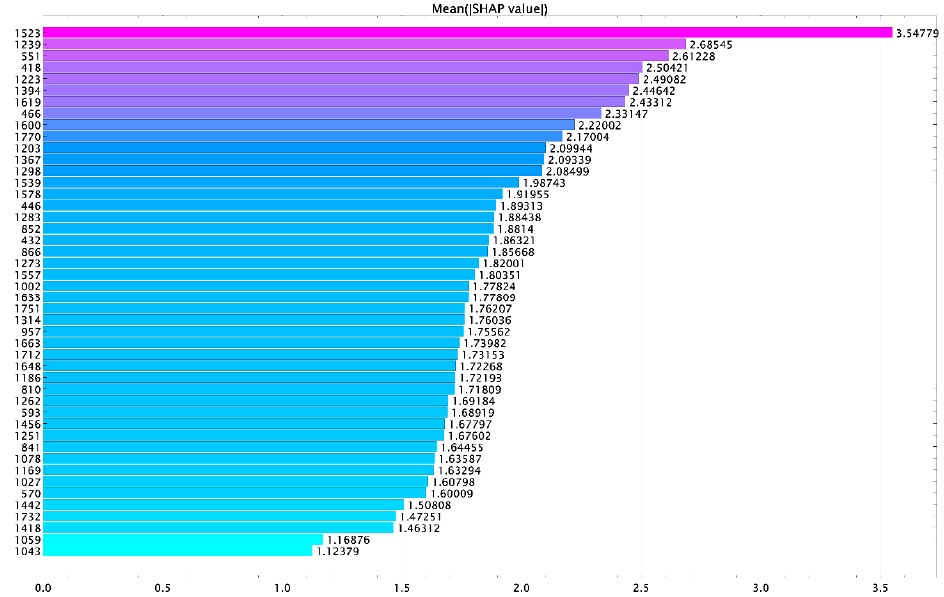
Figure 6. Mean (|SHAP values|). The analysis using the logistic regression method allowed building a discriminative model of the three groups of intensity-specific changes of the dentin, cementum, and enamel Raman lines. The correctly classified changes in the samples with periodontitis were 93% with cross-validation. The calculated values for the group of samples with per- iodontitis were recall = 100%, precision = 86.1%, specificity = 94.8%, AUC = 98.5%. The resulting verification of accuracy of the model was performed using an extra 44 randomly selected measurements that we did not use for the analysis. The model allows classifying the samples with periodontitis with an accuracy of 93%, the samples having professional oral hygiene with an accuracy of 47%, and the samples after the closed curet- tage with an accuracy of 33%. The received data indicate no statistically significant changes in the Raman spectra 6 weeks after the closed curettage as compared to profes- sional oral hygiene. 4. Discussion Despite the existing progress in the study of periodontitis [19–22], our study results are of great importance for the diagnosis and treatment of periodontal diseases, could help significantly improve the quality of life of patients during therapy, and shorten the reha- bilitation period. Our previously published work [22] contained diagnosed spectral changes in the tis- sues of teeth with severe periodontitis and the developed algorithm of verification of tooth enamel with periodontitis to identify at-risk patients and perform diagnostic screening of patients with periodontitis. This work is an extension of our previous research, and aims to assess and correct the main methods of periodontitis treatment (professional oral hygiene and closed curettage) to reveal their efficiency, with the objective to reduce invasiveness and recovery time after treatment.